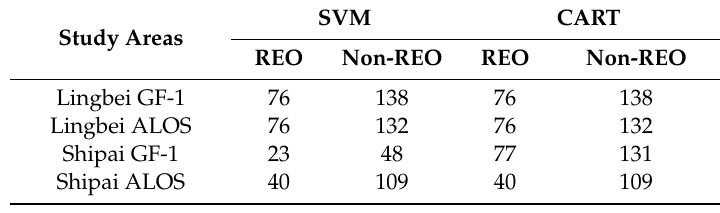
Table 4. Sample numbers of the study areas for SVM and CART methods (unit: objects).